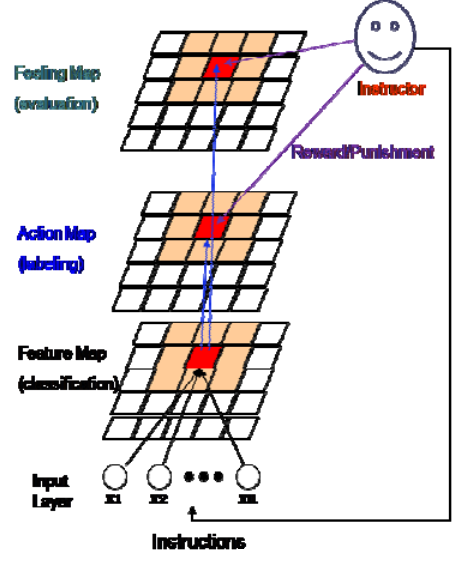
Fig. 3. Insert / Delete a unit to / from a one dimensional ring type SOM.